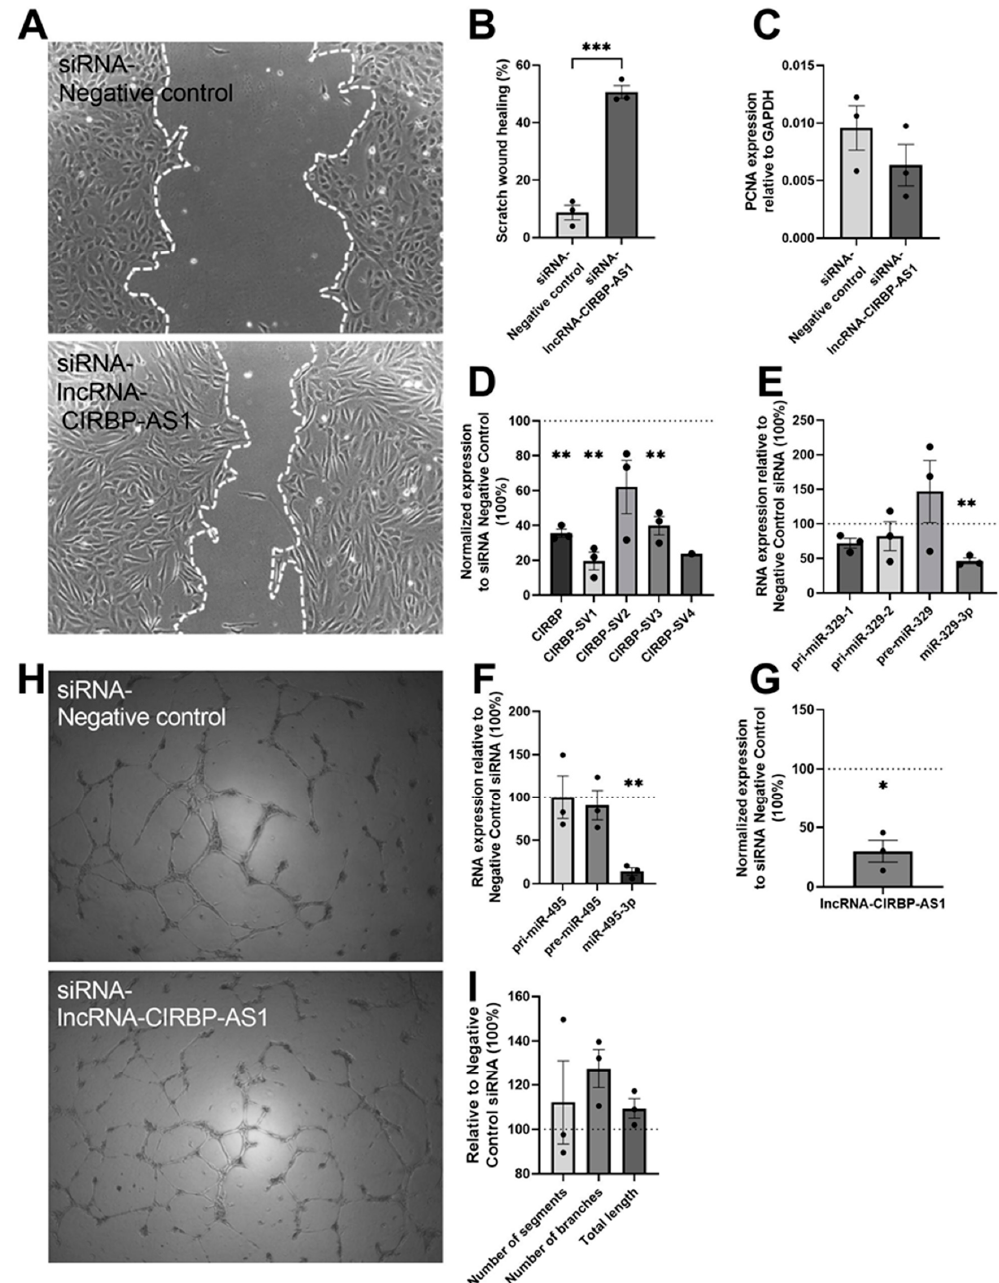
Figure 6. siRNA-lncRNA- CIRBP -AS1 transfection over 24 h in HUVECs: ( A ) Representative images of wound healing ( n = 3) and ( B ) quantification of the migration area, treated with siRNA targeted to lncRNA- CIRBP -AS1 and the negative control for 24 h. White, dotted lines mark the edge of the HUVECs’ monolayer. ( C ) PCNA expression level in HUVECs as an indicator of cell proliferation. ( D ) Total CIRBP expression and its splice variant expression after the scratch assay, normalized to GAPDH. CIRBP -SV4 expression was below the detection limit in two out of three experiments. ( E – G ) After the scratch assay, pri-miRs, pre-miRs, and mature microRNA expression levels of miR-329 and miR-495 were measured and normalized to U6; lncRNA- CIRBP -AS1 expression levels were measured and normalized to GAPDH. Data show the percentage compared to the siRNA negative control group. ( H ) Representative image of the tube formation assay ( n = 3) on HUVECs treated over 24 h with siRNA targeted to CIRBP and the negative control. ( I ) Quantification of the number of segments, number of branches, and total length of the tubes of the HUVECs after siRNA treatment compared to the negative-control siRNA treatment. Data are presented as the mean ± SEM; * p < 0.05; ** p < 0.01; *** p < 0.001; independent sample Student’s t -tests ( B , C ) or one-sample t -tests (two-tail) ( D – G , I